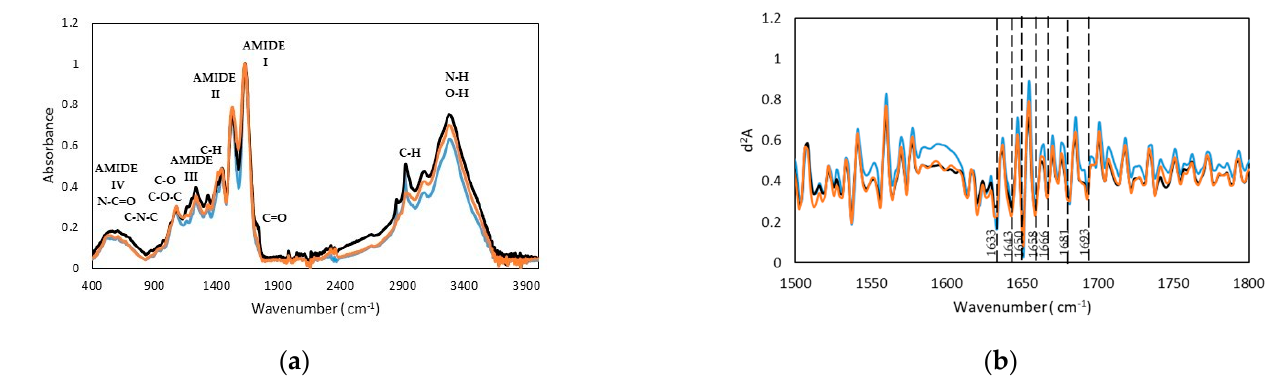
Figure 3. FTIR spectra ( a ) and spectra of the second derivative (differential FTIR spectra, with FDD method) in the absorption region of amide I ( b ), of ( blue line ) seabass, ( ochre line ) trout and ( black line ) seabream gelatins.